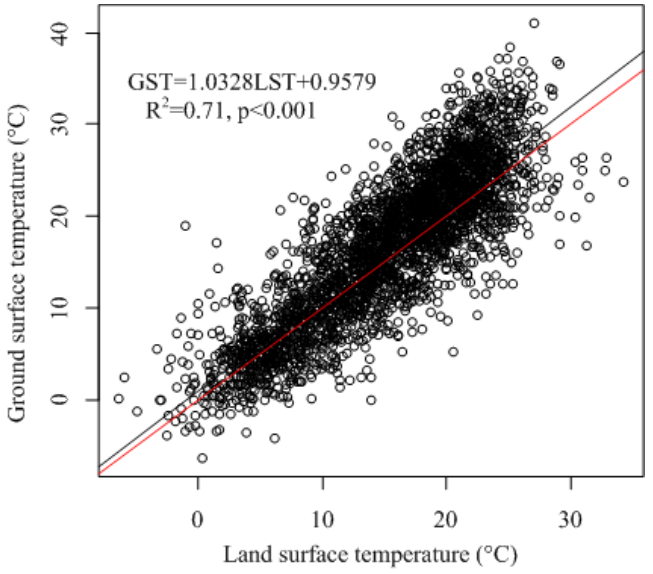
Figure 2. Regression analysis of the linear relationship between ground surface temperature (GST) and land surface temperature (LST) during the thaw period. The red and black lines show 1:1 ratio and the regression line, respectively.